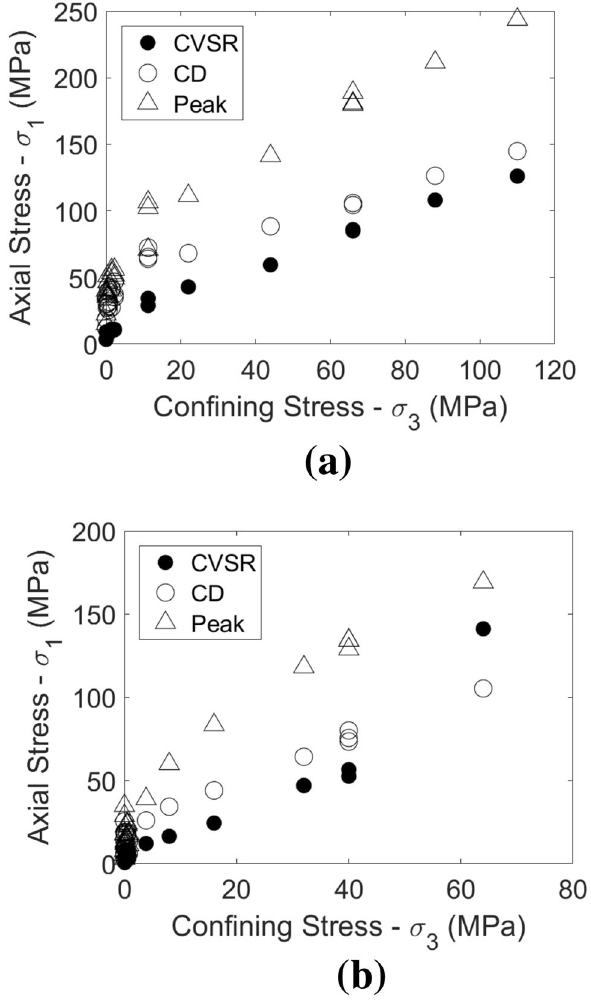
Fig. 6 Crack Volumetric Strain Reversal stress, Crack Damage stress (CD), and peak strength data for 0 (cid:3) included angle ( a ) and 30 (cid:3) included angle ( b ) Note that the crack damage stress was determined as the point of axial strain non-linearity using the tangent modulus reversal method (Eberhardt 1998; Walton et al. 2015,